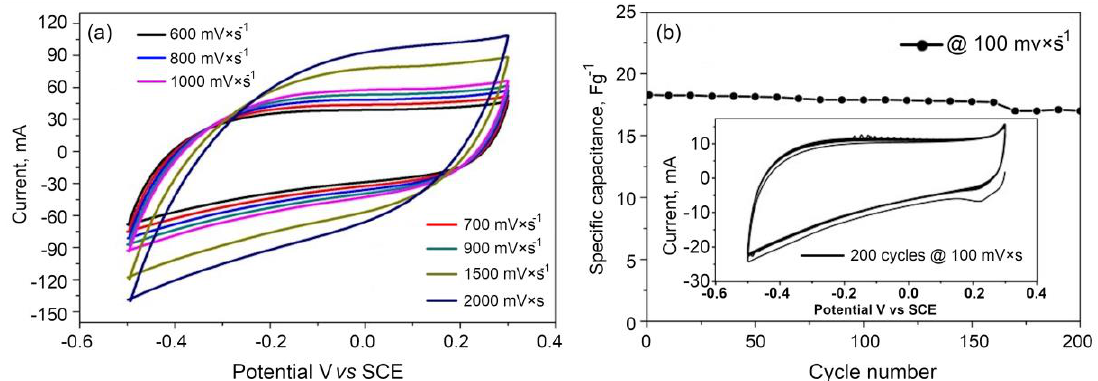
Figure 8. ( a ) CV analysis of the aerogel activated at 800 °C at a higher scan rate, and ( b ) the stability of the 3D carbon aerogel activated at 800 °C.